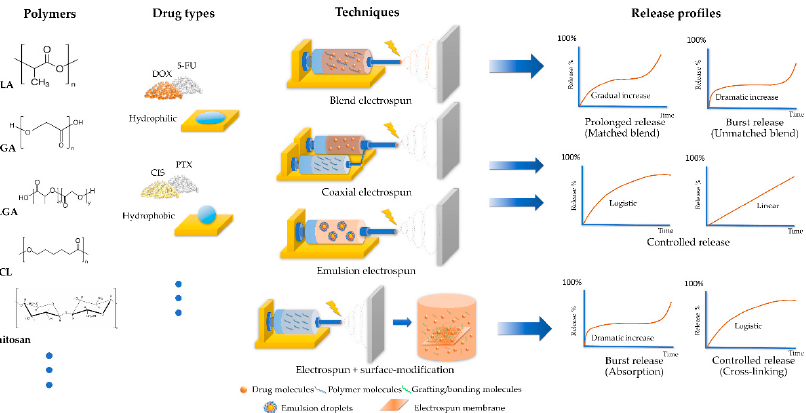
Figure 4. Key factors (polymers, drug hydrophilicity, and electrospinning techniques) affecting the release profiles of chemotherapy drug-loaded electrospun membranes. Combining or using surface- absorbing drugs with hydrophilicity-mismatched polymers would result in a burst release followed by a long stationary phase. Proper matching of drug-polymer hydrophilicity or adapting proper techniques would result in a gradual release with profiles close to logistic or linear